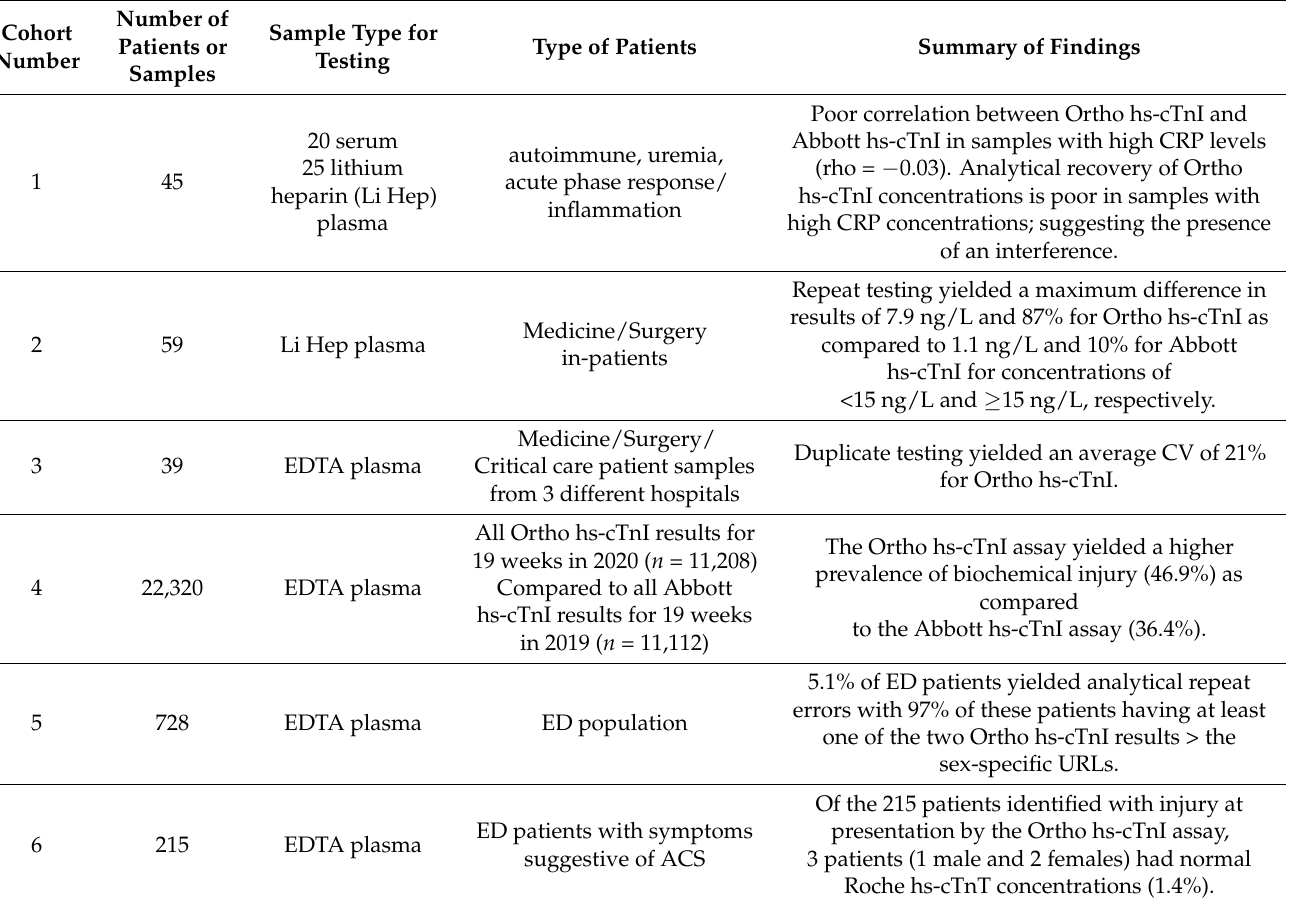
Table 3. Summary of the findings for each of the six cohorts used to characterize the elevated, non-reproducible Ortho hs-cTnI